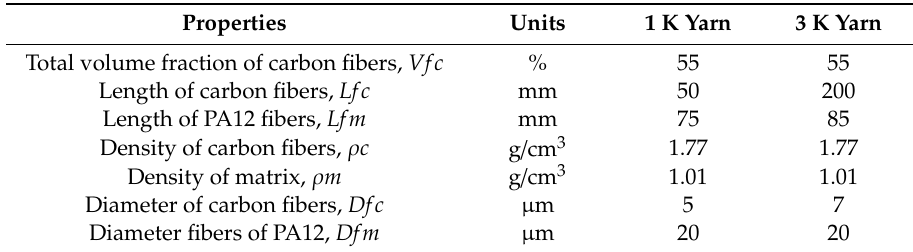
Table 4. Properties of TPFL ® hybrid filament